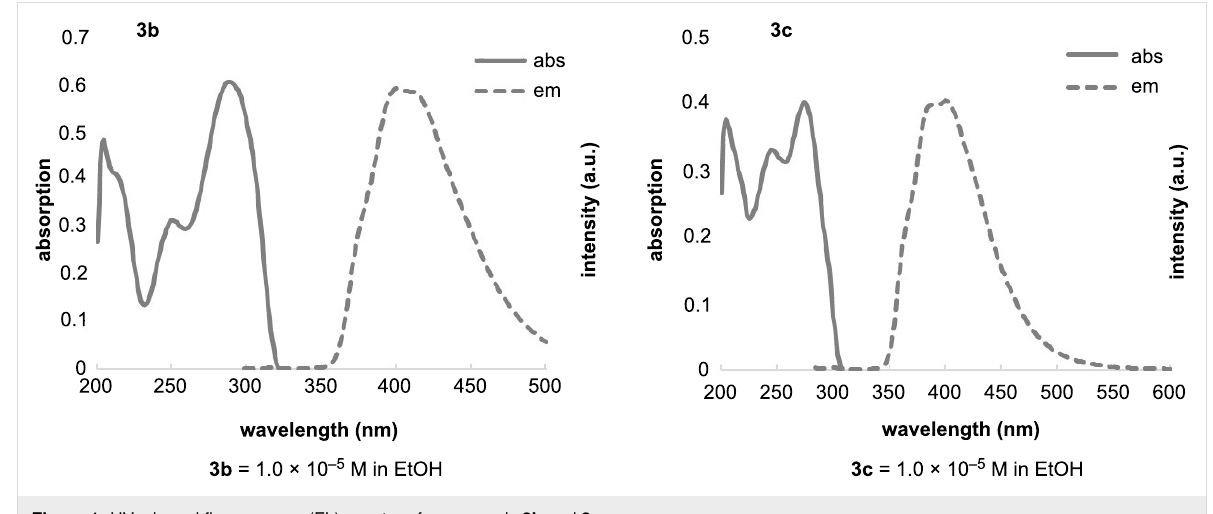
Figure 1: UV–vis and fluorescence (FL) spectra of compounds 3b and 3c .